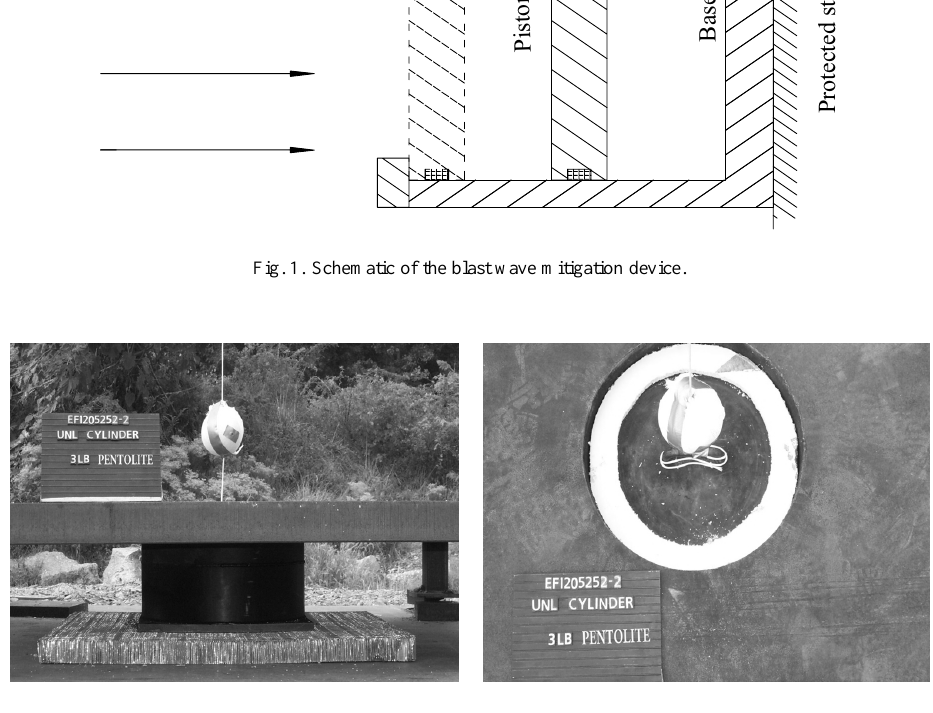
Fig. 2. The first experimental setup for the explosive charge